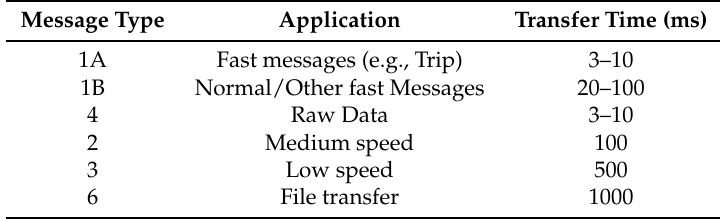
Table 4. IEC 61850-90-1 transfer time requirements [36,38].